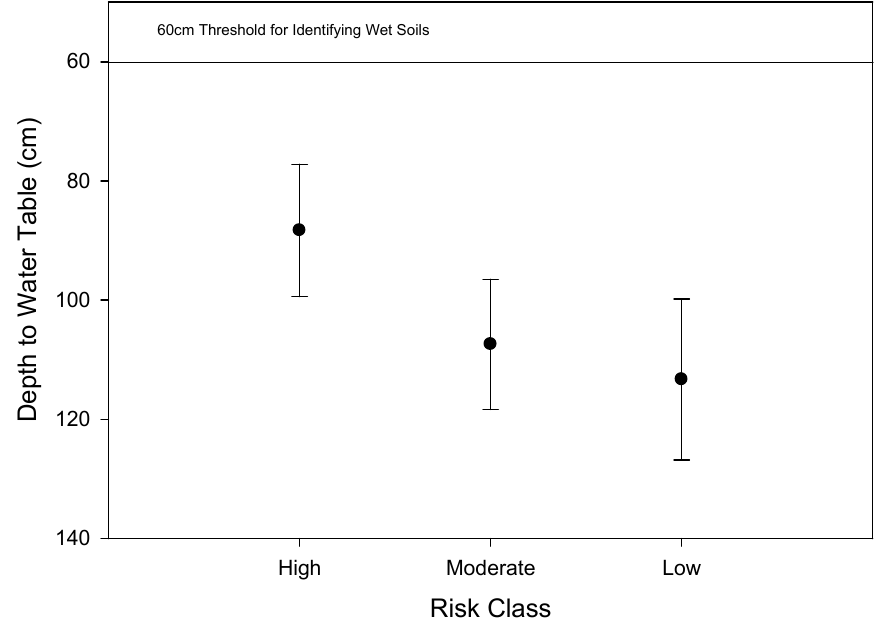
Figure 5. Average depth to water table at the summit slope location for each hazard